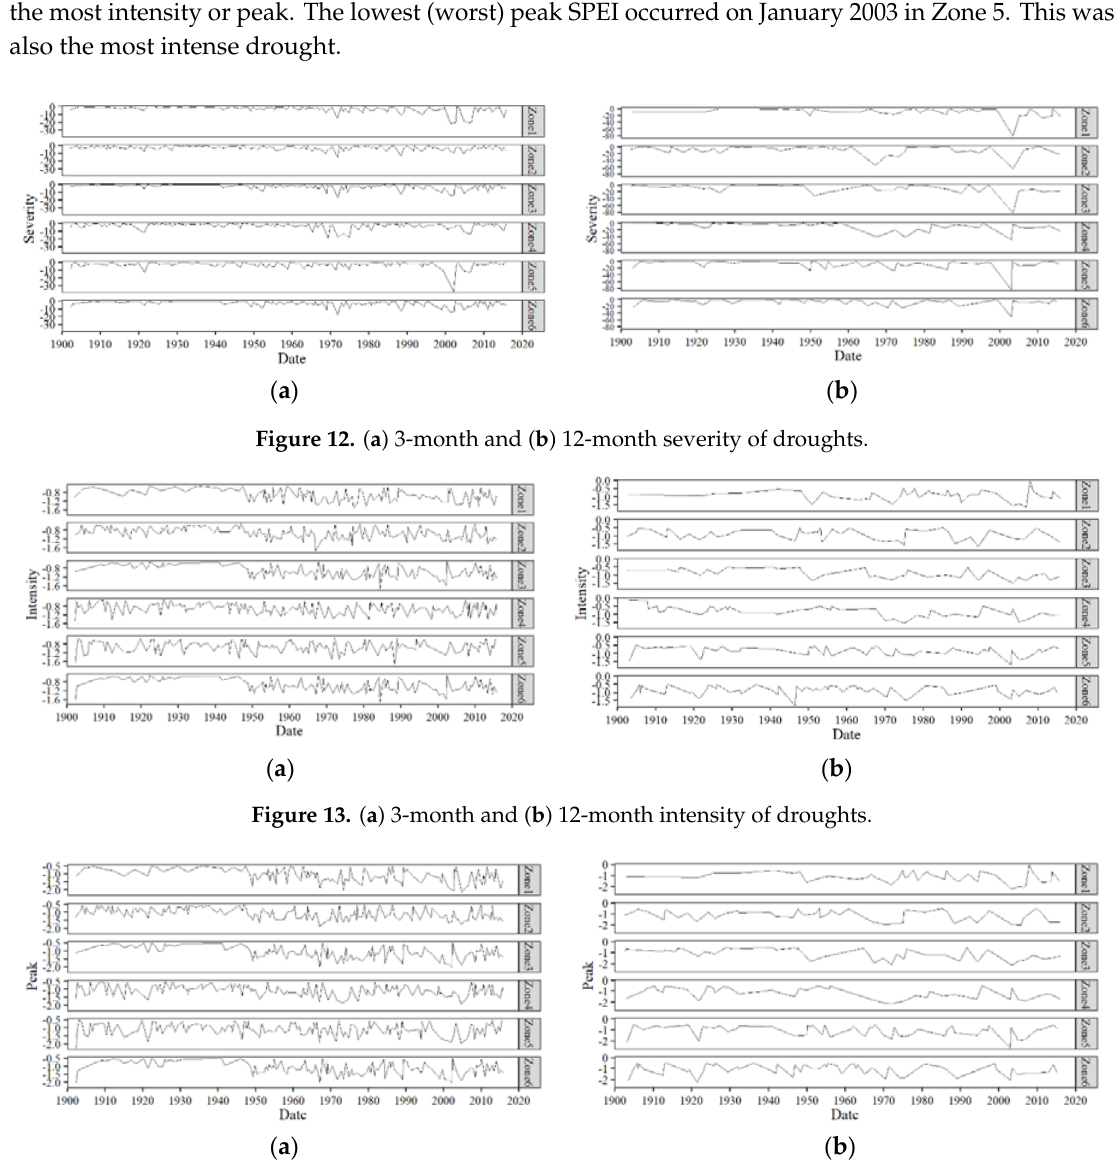
Figure 14. ( a ) 3-month and ( b ) 12-month peak of Figure 14. ( a ) 3 ‐ month and ( b ) 12 ‐ month peak of droughts. Figure 14. ( a ) 3 ‐ month and ( b ) 12 ‐ month peak of droughts. Table 1. Mann–Kendall test results for 3 ‐ month SPEI. Table 1. Mann–Kendall test results for 3 ‐ month SPEI.